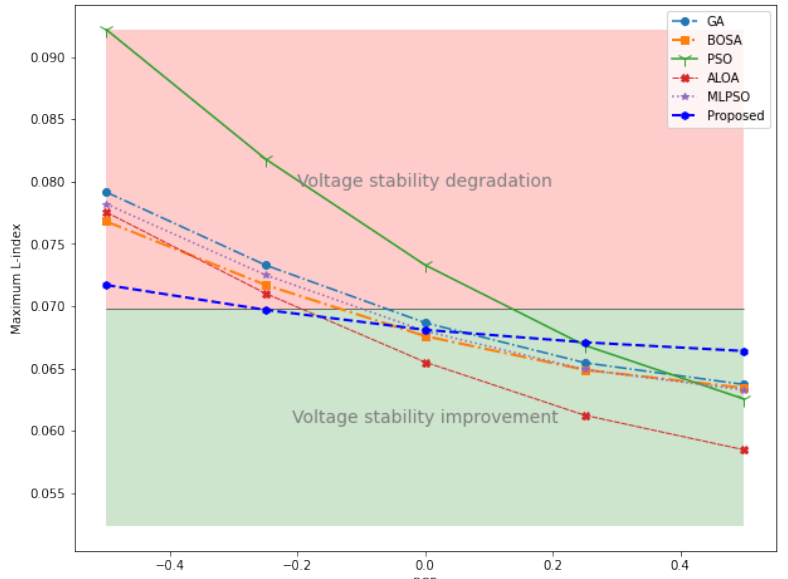
Figure 11. Variation of voltage stability with reactive compensations of 2 RDGs using maximum L